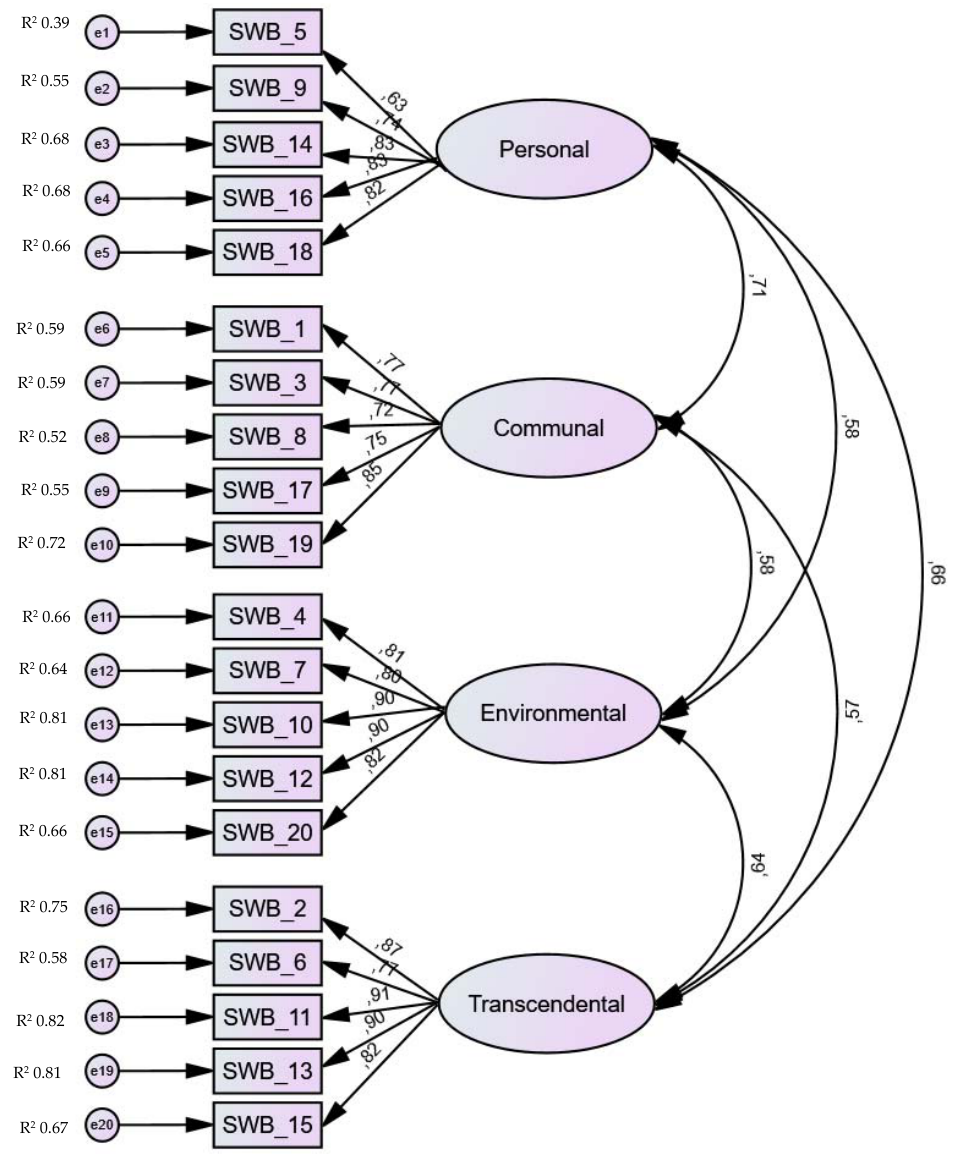
Figure 1. Confirmatory factor analysis (CFA) of the SWBQp four-factor oblique model (Model 1). All the items had approximate estimate values, further confirming they all contributed with similar weight to the study (Figure 1), and the most important ones were item 11, item 13, item 10, and item 12 (with a 0.9 value each). Item 5 (0.63) was the least important among them all. Figure 1 presents standardized factor loadings for each item and all measuring items had acceptable values equal to or higher than 0.6 (Awang 2012) for the respective latent factor. This finding indicated that the factors explained these items well, and around 50% of the variance was explained (squared multiple correlations ( R 2 ) ≈ 0.5) by the predicted variables. As such, the factors explained all the items well. Therefore, no item was deleted, and the measurement model was found to be appropriate. Standardized factor correlations were highest between the personal and communal factors (0.71).